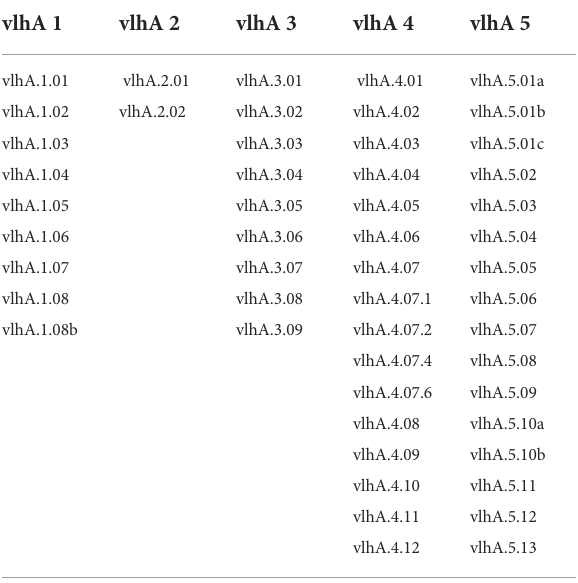
TABLE 1 List of vlhA genes based on their group analyzed in this